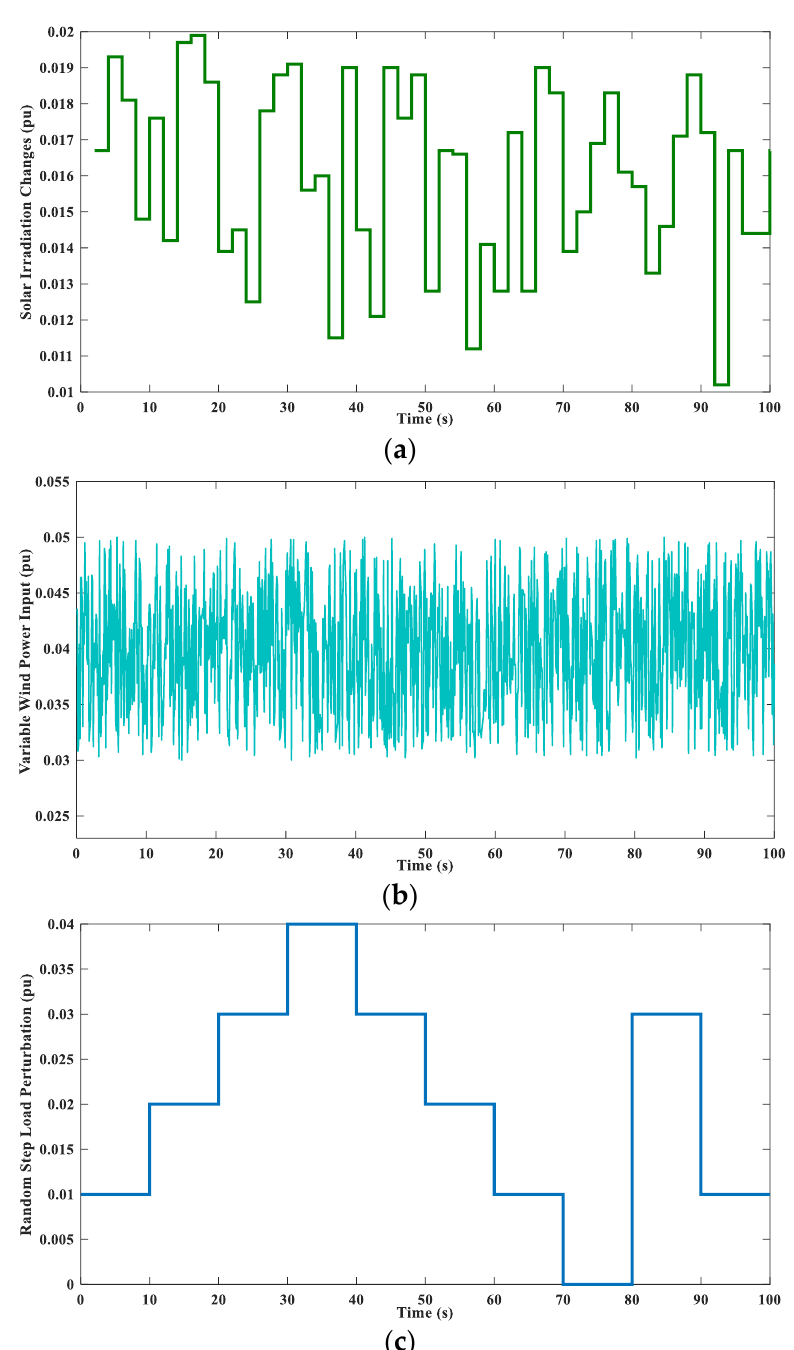
Figure 5. Random patterns of: ( a ) load demand, ( b ) wind power input, and ( c ) solar irradiance. Table 7. FOPID controller gain for RLD, variable solar irradiations, and irregular wind power.